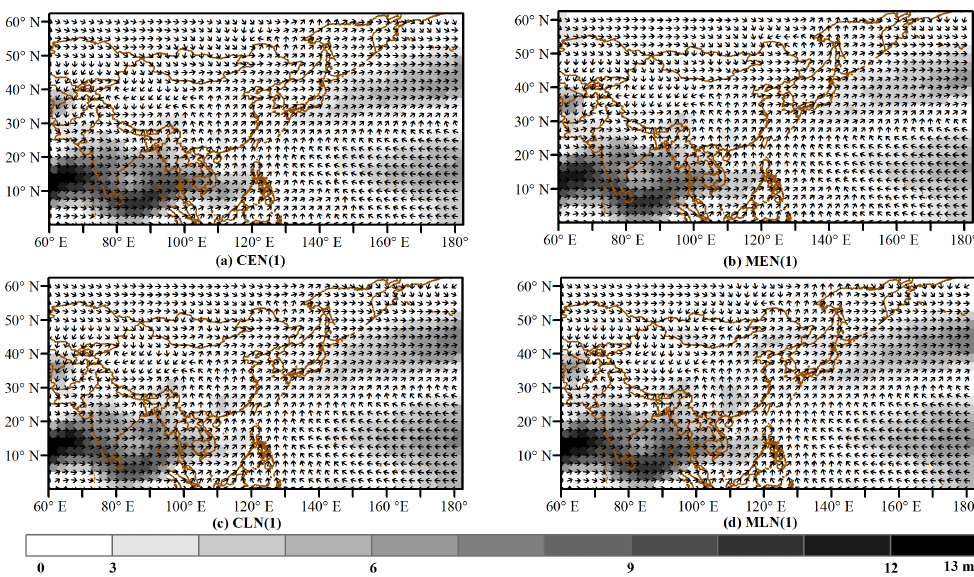
Figure 7. Composites of 850mbar vector wind for mainland China during ENSO and ENSO Modoki decaying (1) phases. Arrows show the direction of wind (ms − 1 ); grey shaded areas denote wind speed above 3ms −